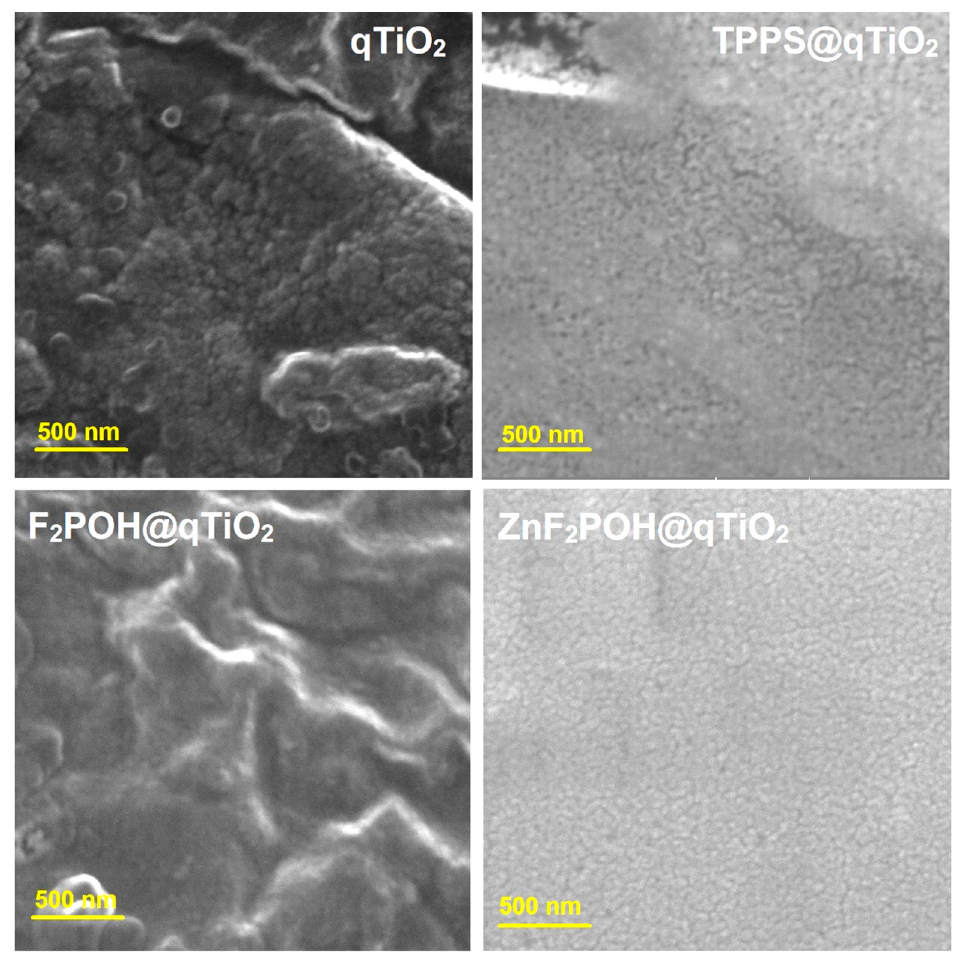
Figure 3. SEM images of nanostructured qTiO 2 , TPPS@qTiO 2 , F 2 POH@qTiO 2 , and ZnF 2 POH@TiO 2 recorded on carbon tape.